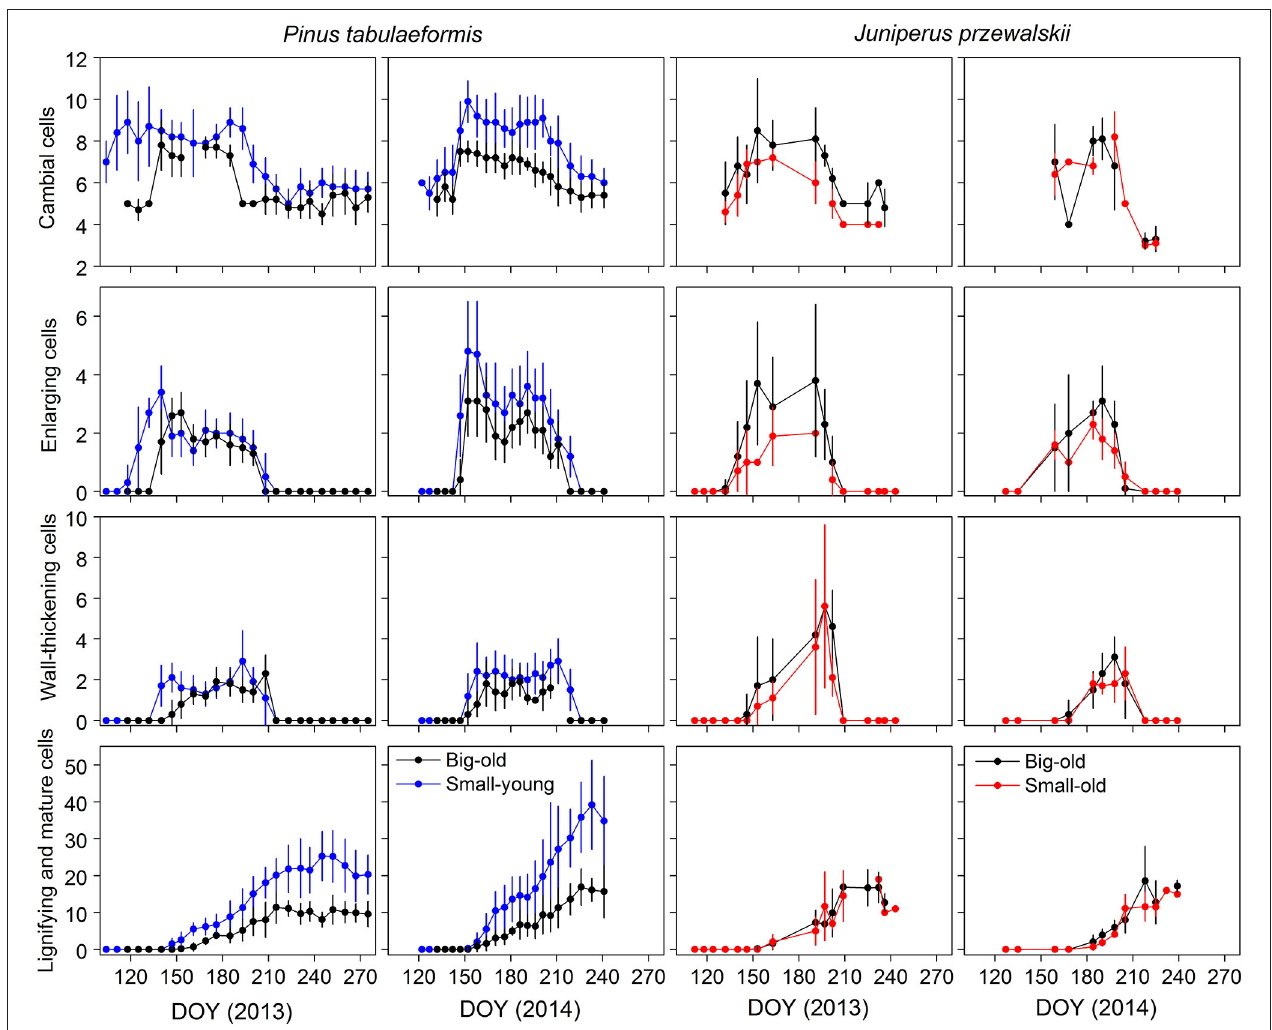
FIGURE 3 | Number of cells during the different phases of xylem differentiation of trees for the different groups and sites in 2013 and 2014. Error bars indicate standard deviations for sampling trees per sampling date.